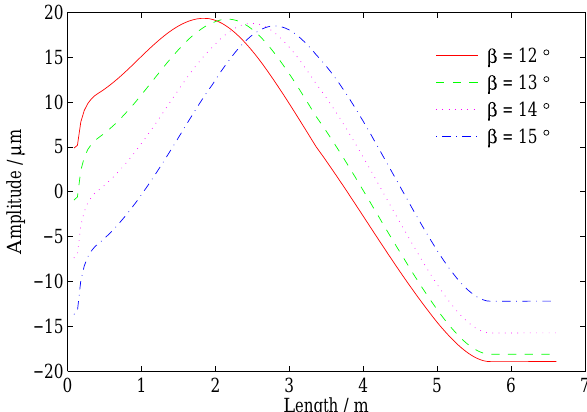
Table 2. Main parameters of the reducer bearing.